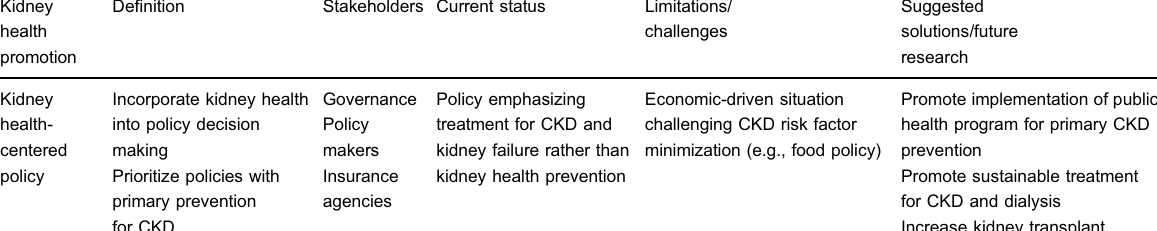
Table 1. Summary of kidney health promotion strategies, involving kidney health policy, community kidney health planning, and kidney health literacy, and proposed future